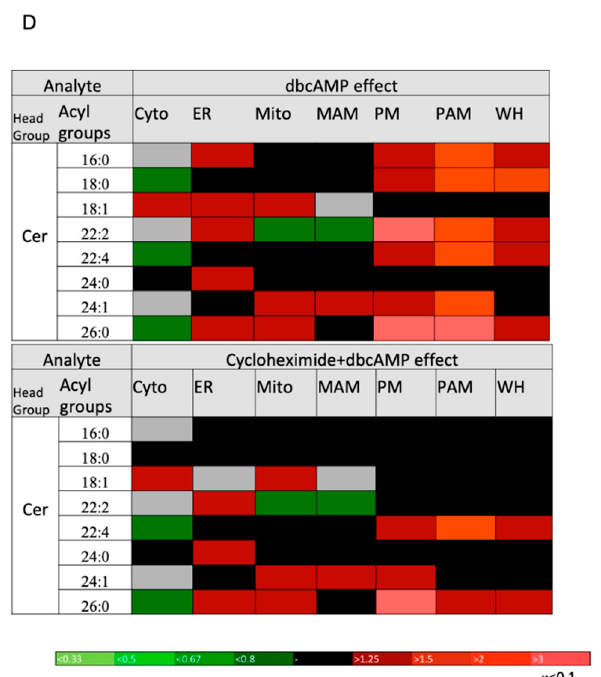
Figure 5. Cholesteryl ester, cardiolipin, and ceramide distribution profiles in subcellular fractions. ( A ) Cholesteryl ester, ( B ) cardiolipin, and ( C ) ceramide abundance in cytosol (Cyto), endoplasmic reticulum (ER), mitochondria (Mito), mitochondria-associated membrane (MAM), plasma membrane (PM), and plasma membrane-associated membrane (PAM) fractions, as well as whole cell extract (WC) from control, dbcAMP-treated, and dbcAMP plus cycloheximide-treated MA-10 cells. ( D ) Heat map analysis showing changes in ceramide (Cer) levels in response to stimulation with dbcAMP and dbcAMP plus cycloheximide in MA-10 cells. Acyl groups are abbreviated by the number of carbon atoms and double bonds per molecule. Changes are color coded according to the statistical significance table at the bottom of the figure. Data shown are the average of results for each molecular species, mean ± SEM; n = 4. * p <